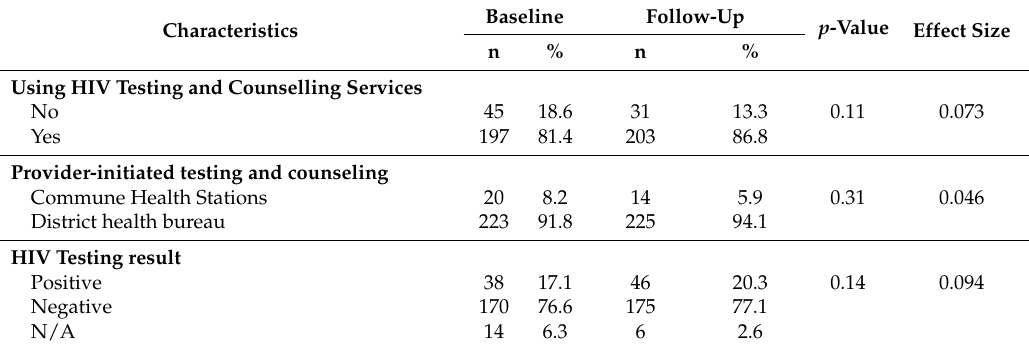
Table 3. Change in the uptake of HIV testing services among methadone maintenance treatment